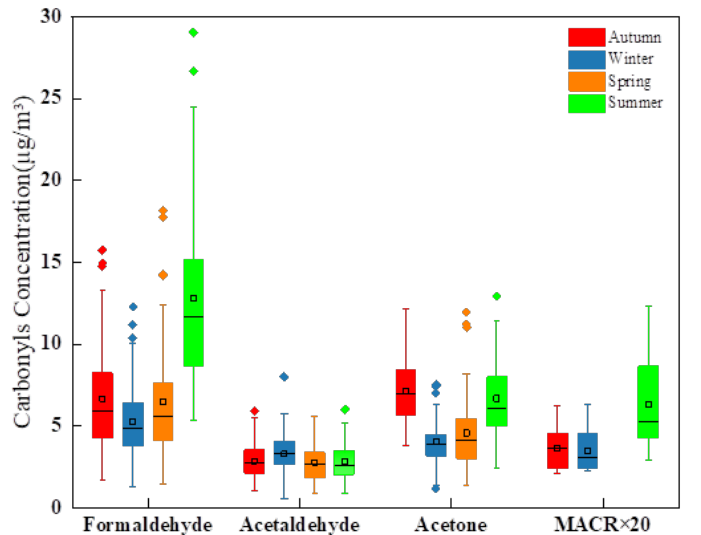
Figure 2. Seasonal variations of formaldehyde, acetaldehyde, acetone and MACR×20 in Taiyuan.